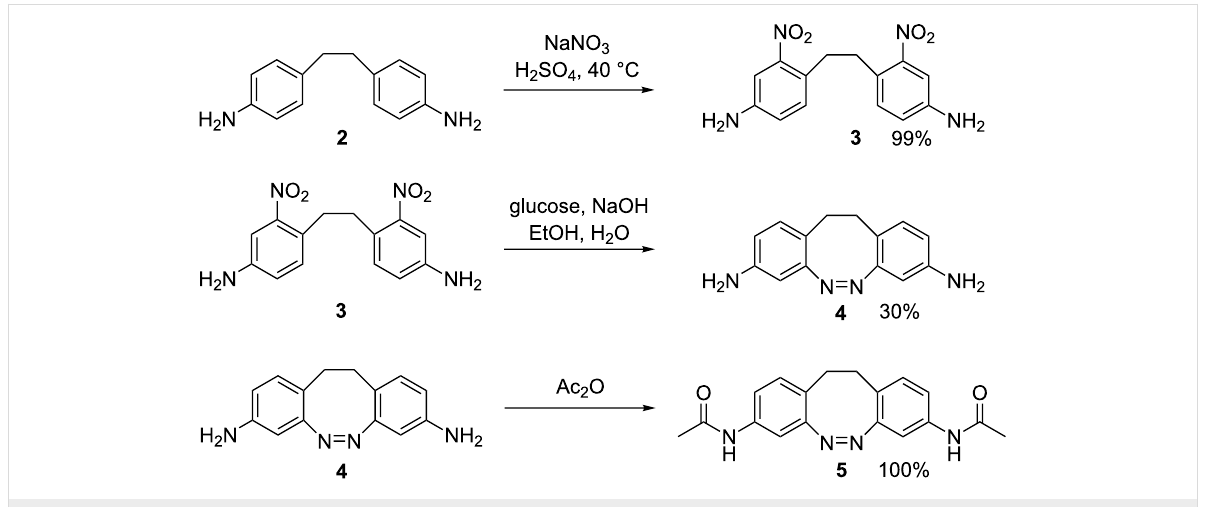
Scheme 1: Synthesis of 3,3’-diamino-EBAB 4 and its acetamide derivative 5 .